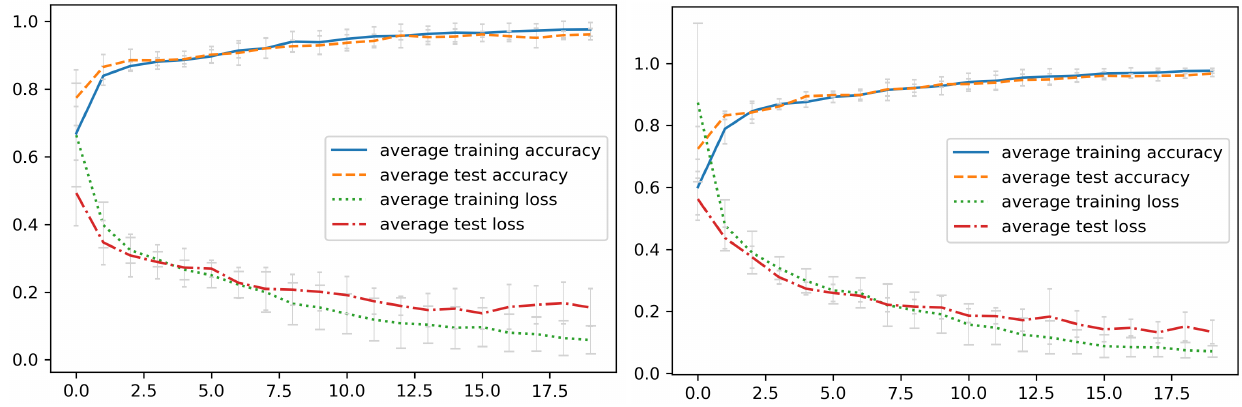
Figure 10. Summary of average results for 20 iterations. Class 0 vs. III. Model: the LeNet model from Figure 5 was applied. Validation method: cross-validation 5. Accuracy for 20 iterations of neural network training.